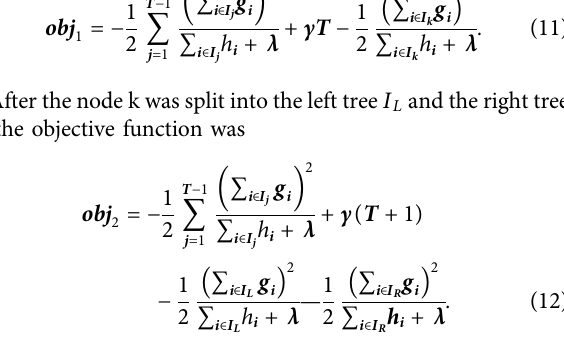
Frontiers in Genetics |